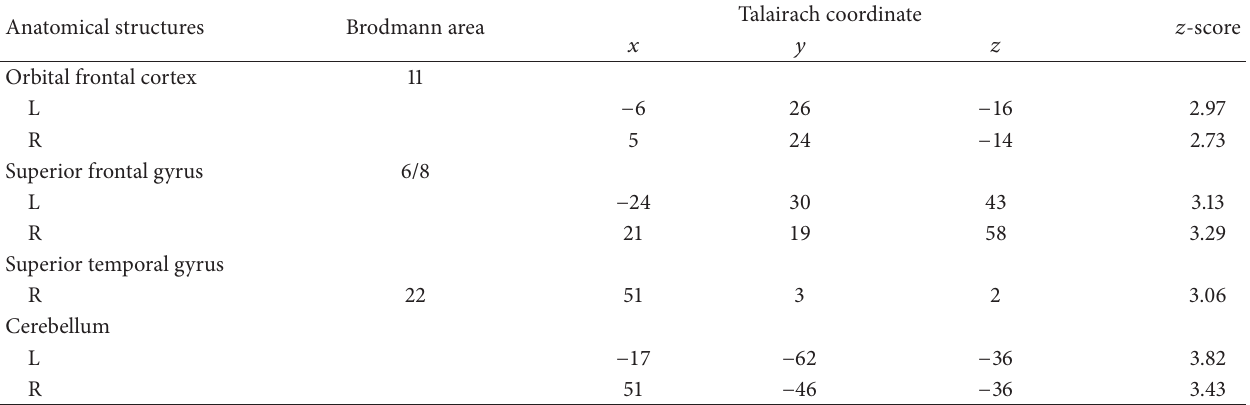
Table 4: Regions showing significant changes in rCBF by the subtraction of chord minus simple condition.